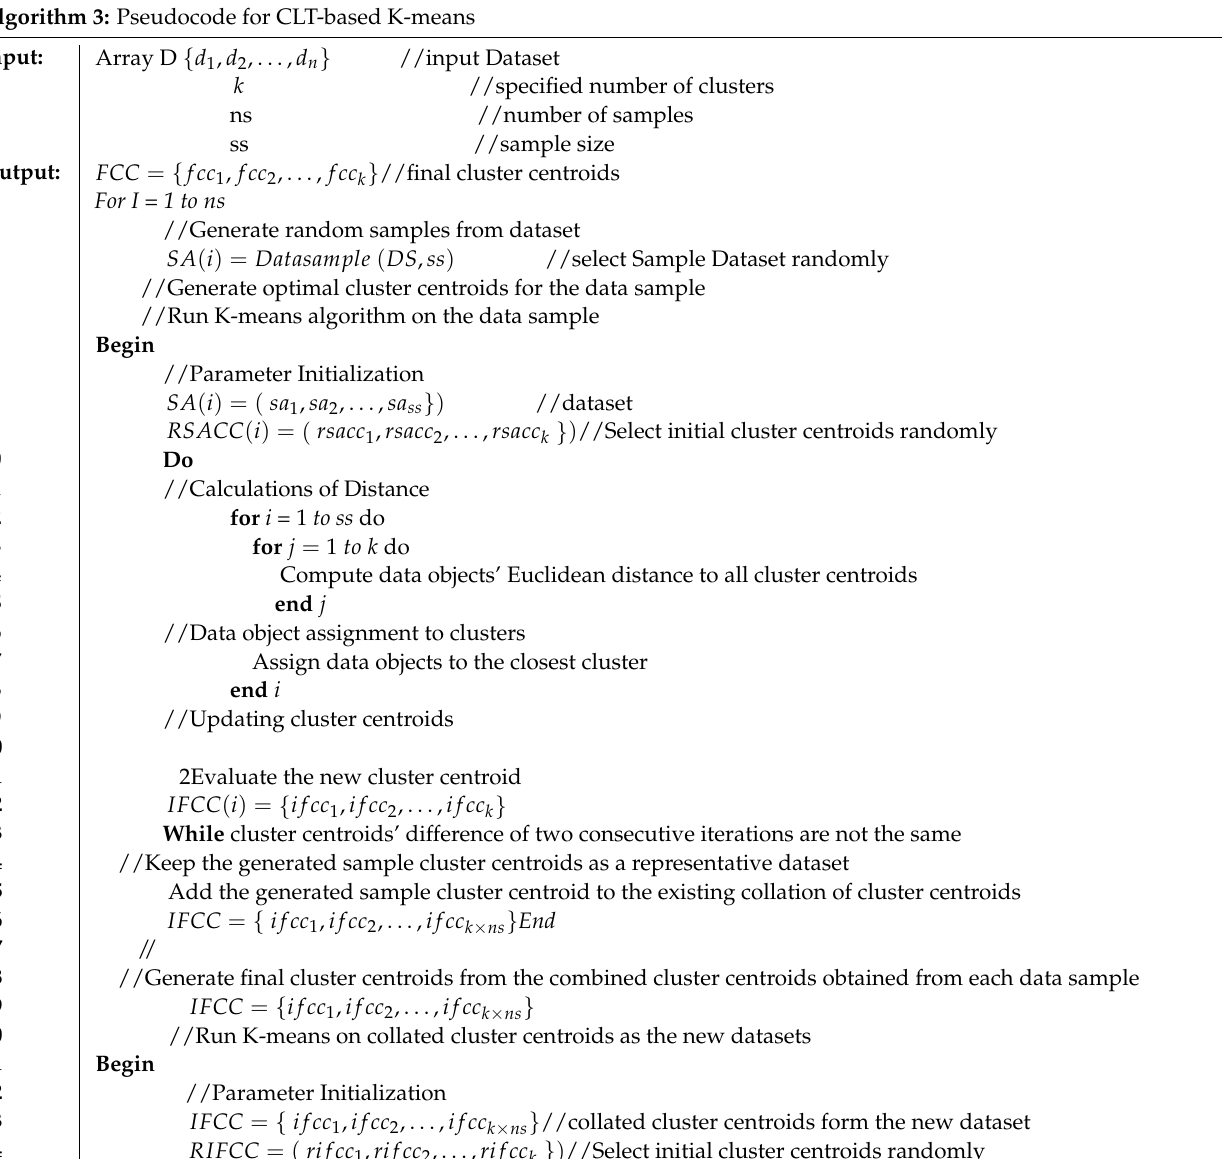
Algorithm 3: Pseudocode for CLT-based